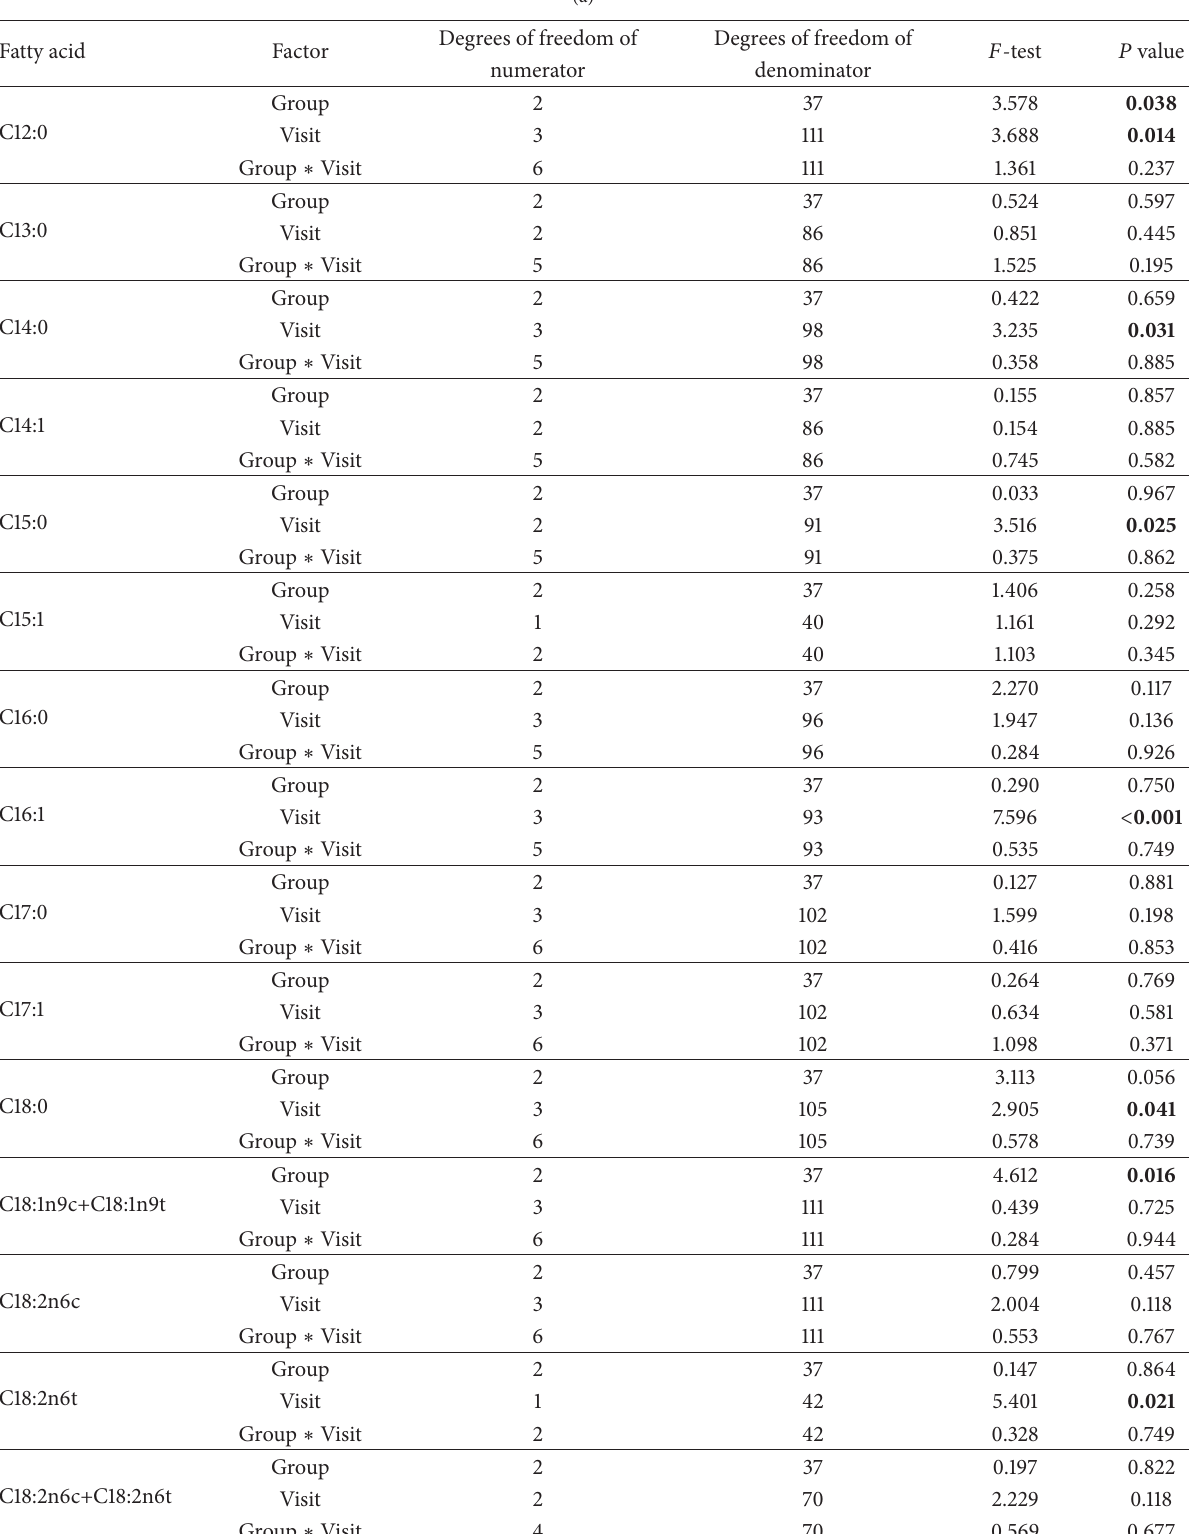
Table 4: (a) Results of analysis of variances (ANOVAs) for every fatty acid from C12:0 to C18:2n6c+C18:2n6t, based on group treatment and visit. (b) Results of analysis of variances (ANOVAs) for every fatty acid from C18:3n6 to C24:0 (with squalene and total identified fatty acids), based on group treatment and